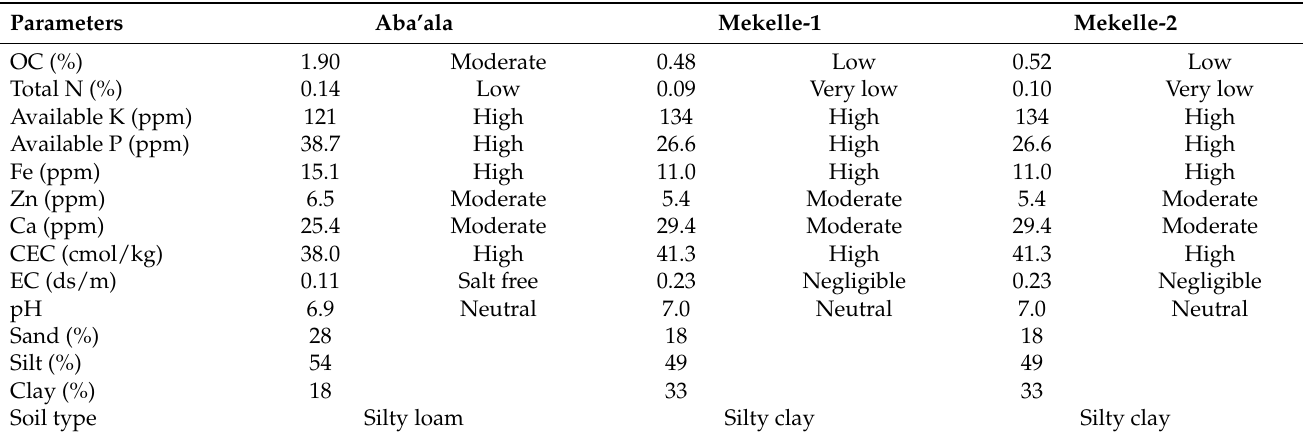
Table 1. Soil chemical and physical properties at the investigated sites.